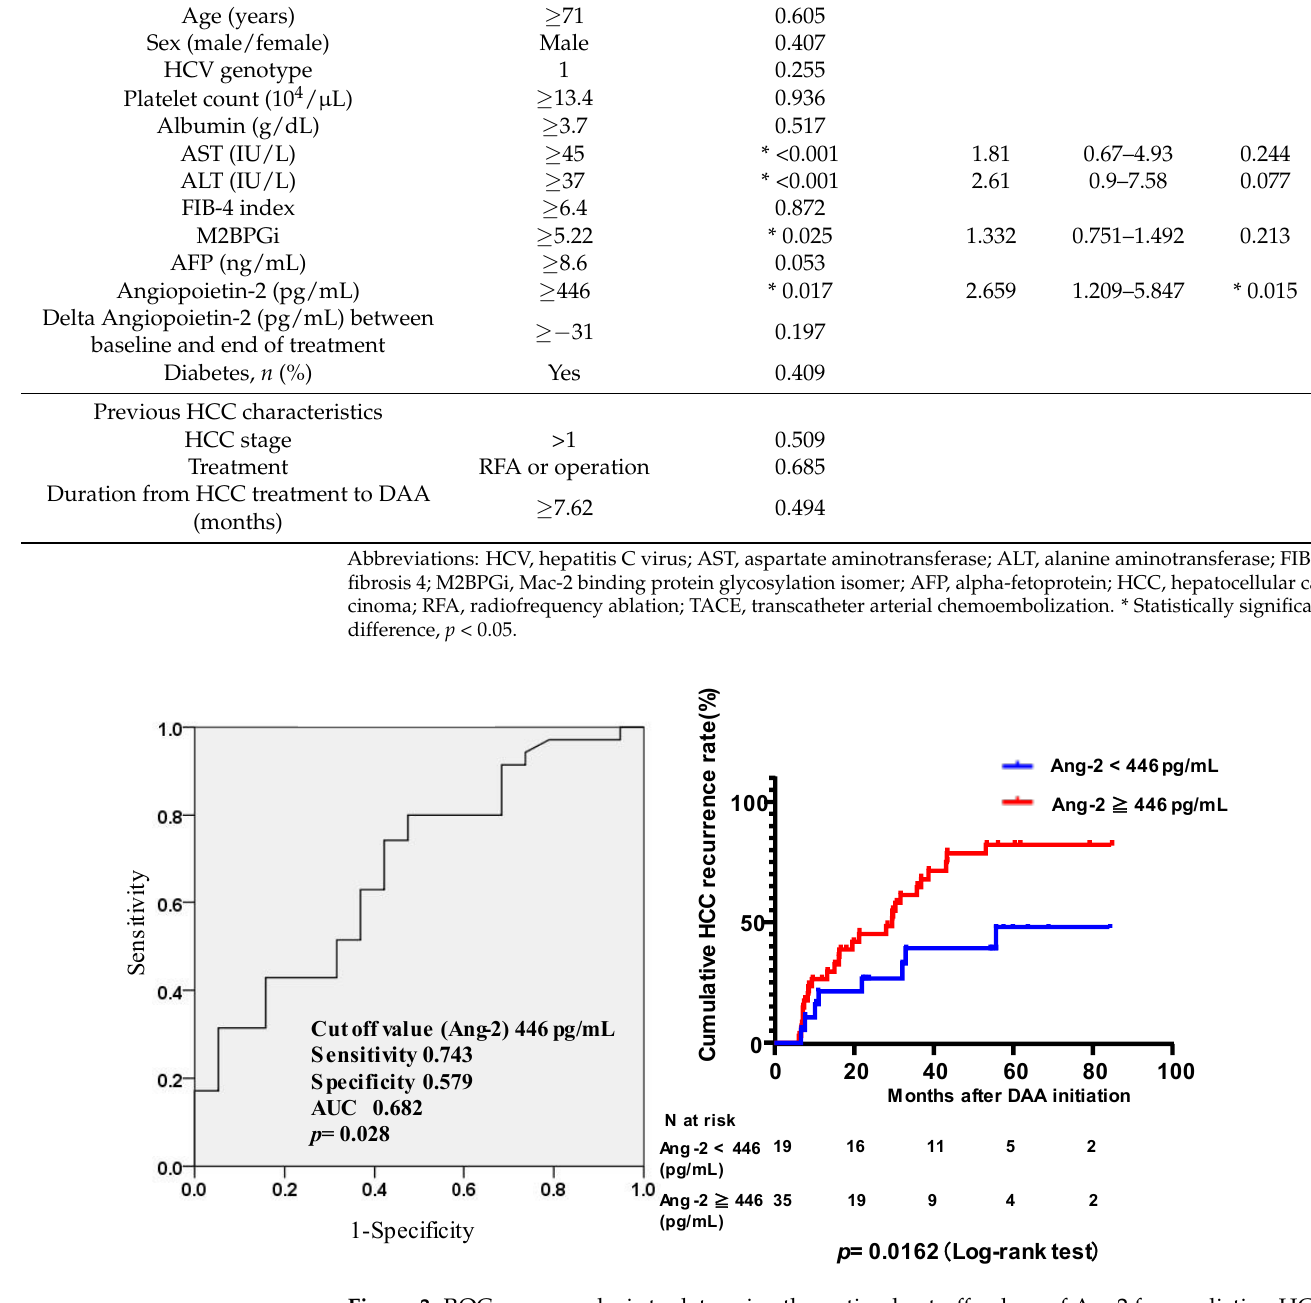
Figure 3. ROC curve analysis to determine the optimal cut-off values of Ang2 for predicting HCC recurrence and cumulative incidence of HCC recurrence following the initiation of DAA therapy.